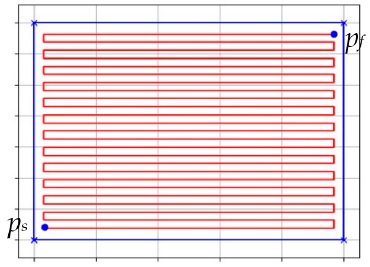
Figure 1. Proposed concept for path planning, the red line represents the generated path based on the starting point ( ps ), finish point ( pf ), and the ROI (blue polygon).